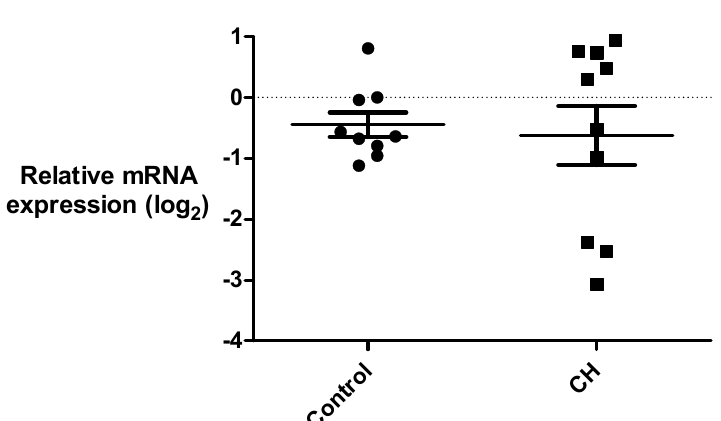
Figure 2. ANO3 mRNA levels in cluster headache (CH) patients and controls. Relative mRNA levels of ANO3 in primary fibroblast cell lines from 9 control individuals and 10 CH patients. mRNA levels were normalized to reference genes TBP and IPO8 , and to a control sample. Relative expression levels were log 2 -transformed due to non-normal distribution of the data, and analyzed with Student’s t-test, p -value = 0.75.